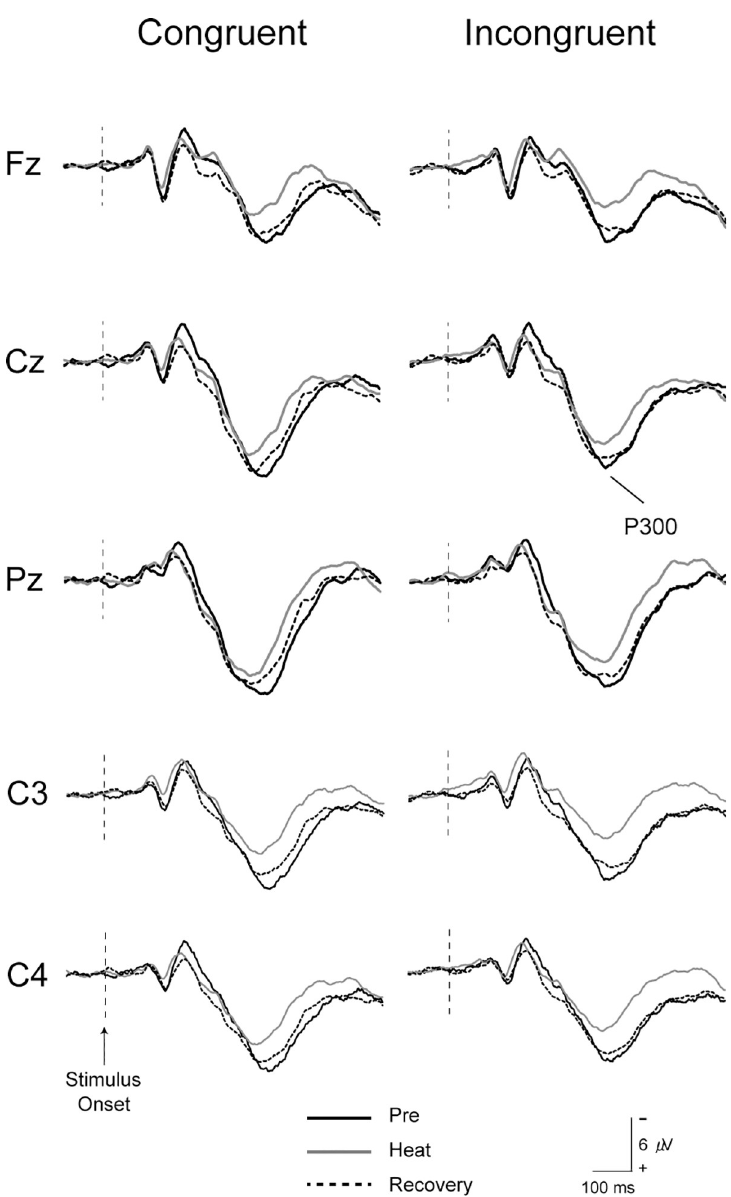
Fig 3. Grand-averaged EPP waveforms for each session across all subjects. Black lines indicate waveforms at Pre, gray lines show waveforms at Heat, and dotted lines show waveforms at Recovery.